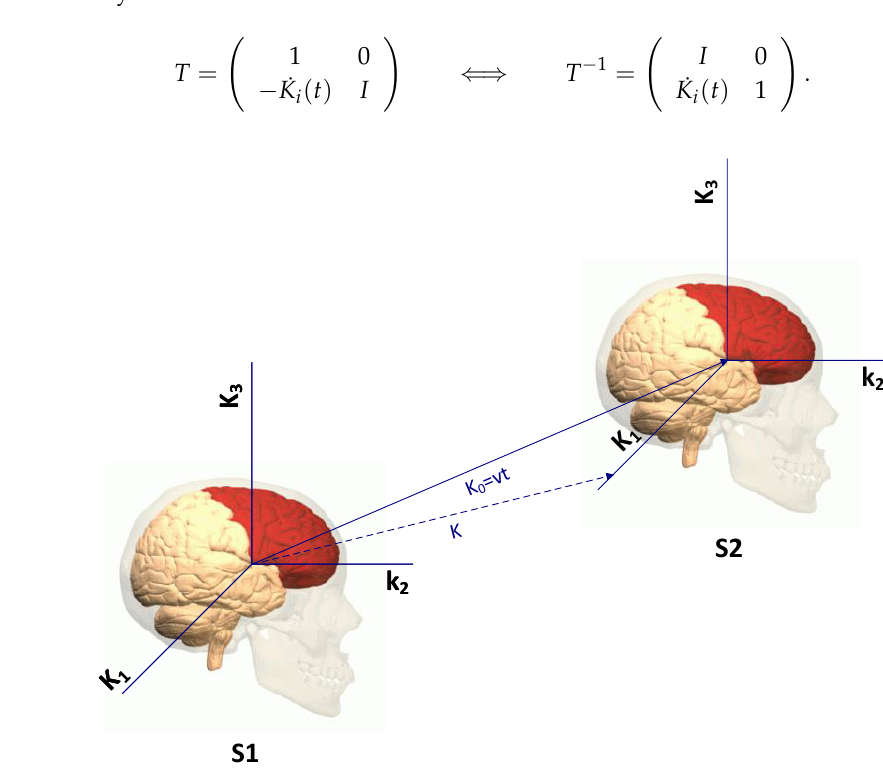
Figure 1. Learning Brain over Space and